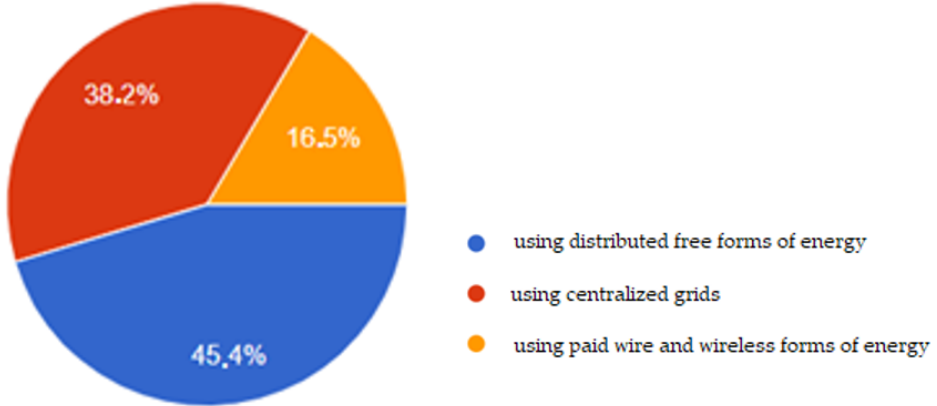
Figure 3. Which energy-saving model would you and your family prefer?